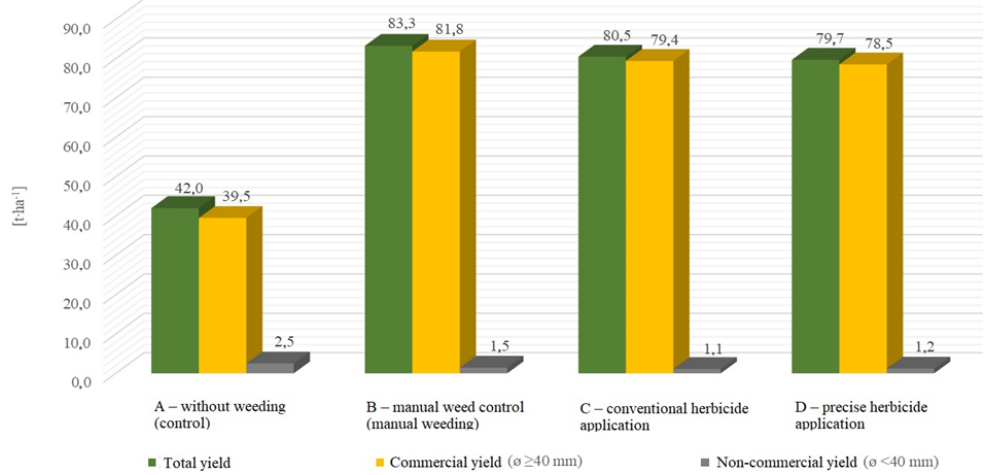
Figure 3. Average onion yield in 2016 (source: own work).